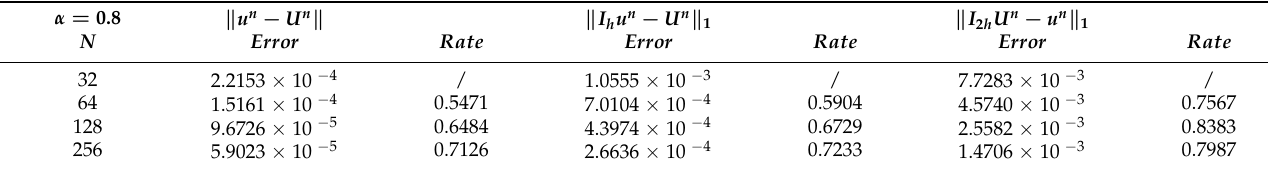
Table 6. Temporal numerical results of r = 1 on graded meshes to Example 2.